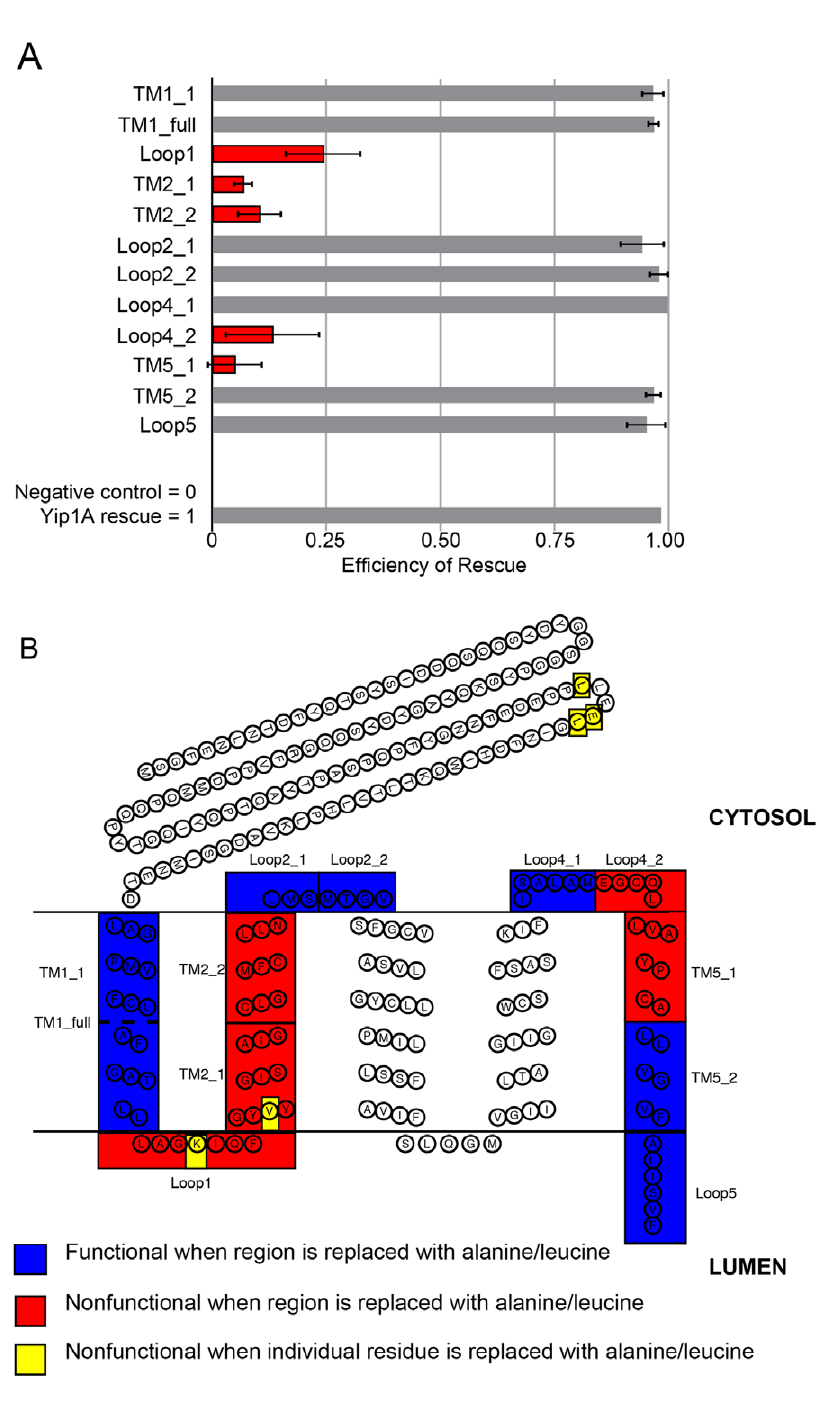
doi:10.1371/journal.pone.0054413.g002